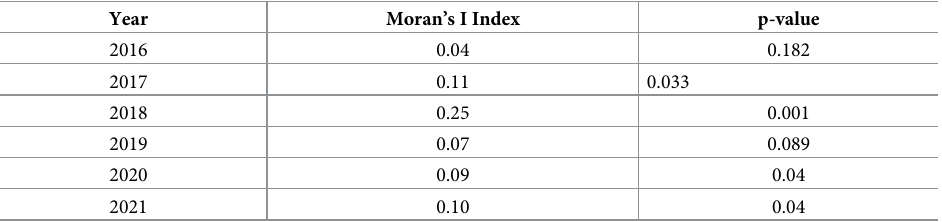
Table 1. Global Moran’s I indices returned for the years